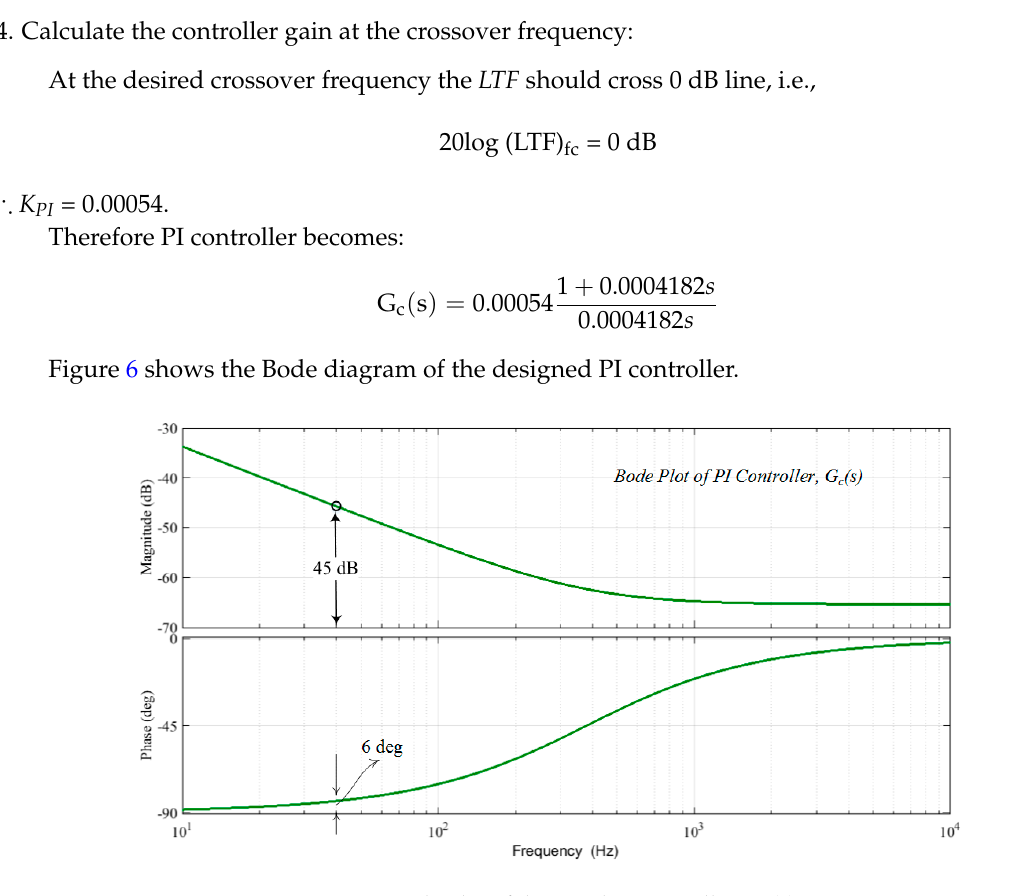
Figure 6. Bode plot of designed PI controller, G c (s).